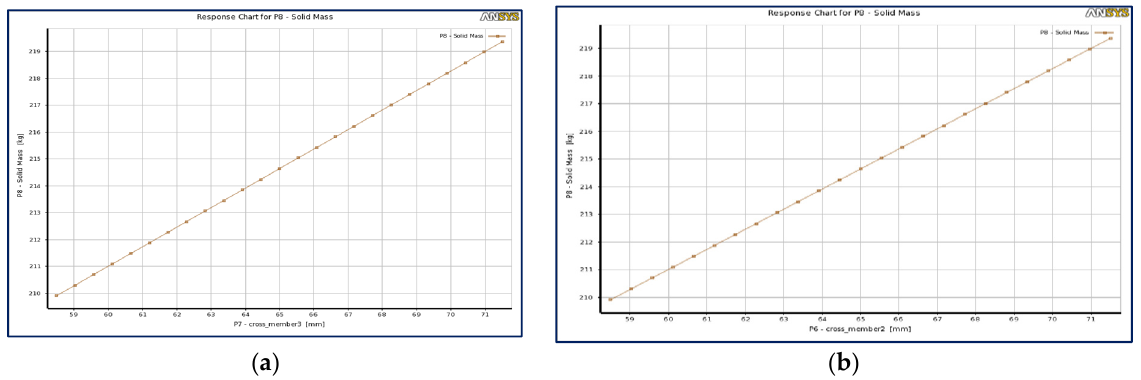
Figure 24. Solid mass vs. cross member 3 ( a ) for CCD scheme, and ( b ) for optimal space filling design.